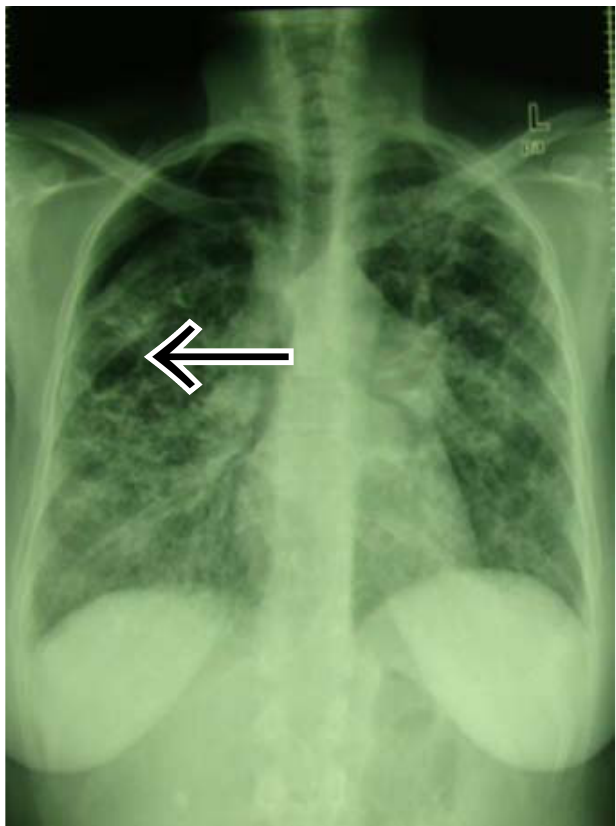
Fig. 11a. Frontal chest X-ray with interstitial fibrosis of NF1 complicated by spontaneous pneumothorax on the